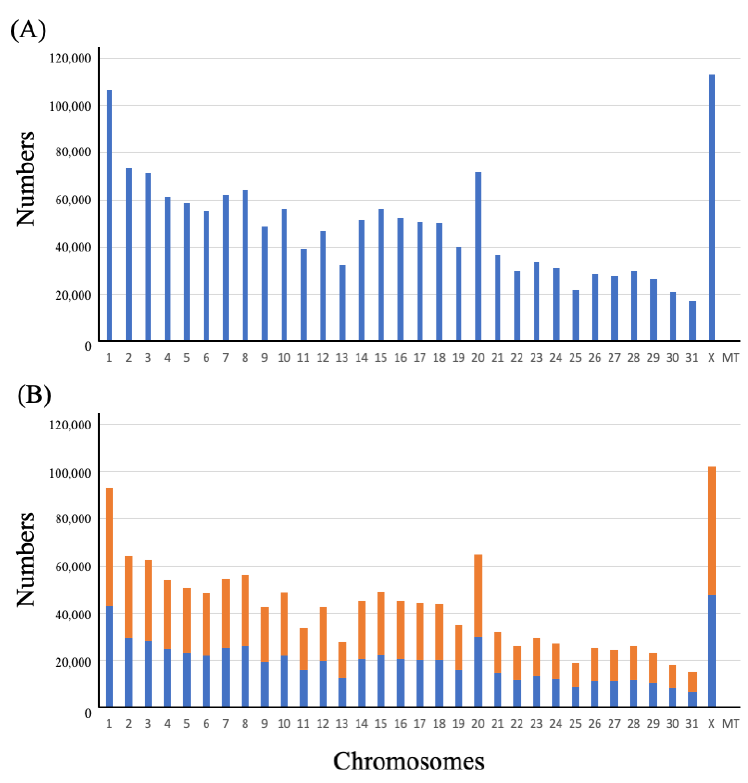
Figure 1. Distribution of insertions and deletions (INDELs) detected in 101 Thoroughbred horses. ( A ) Distribution of all INDELs identified on chromosomes 1–31, X, and MT; and ( B ) Distribution of insertions and deletions of diallelic INDELs on chromosomes 1–31, X, and MT (blue: insertions; orange: deletions).